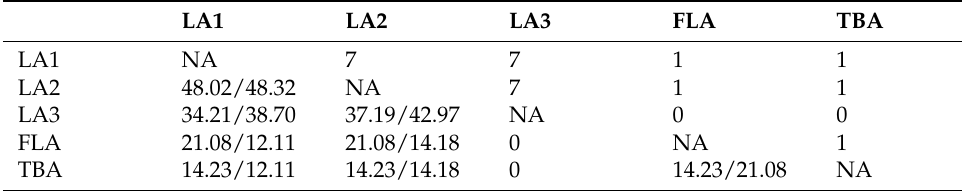
Table 3. Summary of the overlap between QTLs controlling different angles. Upper right, the number of QTLs overlapping between two traits. Lower left, the percentage of variance explained by overlapping QTLs. The number to the left of the slash is variance explained for the trait in the same row and the number to the right of the slash is for the trait in the same column. LA1 LA2 LA3 FLA TBA LA1 NA 7 7 1 1 LA2